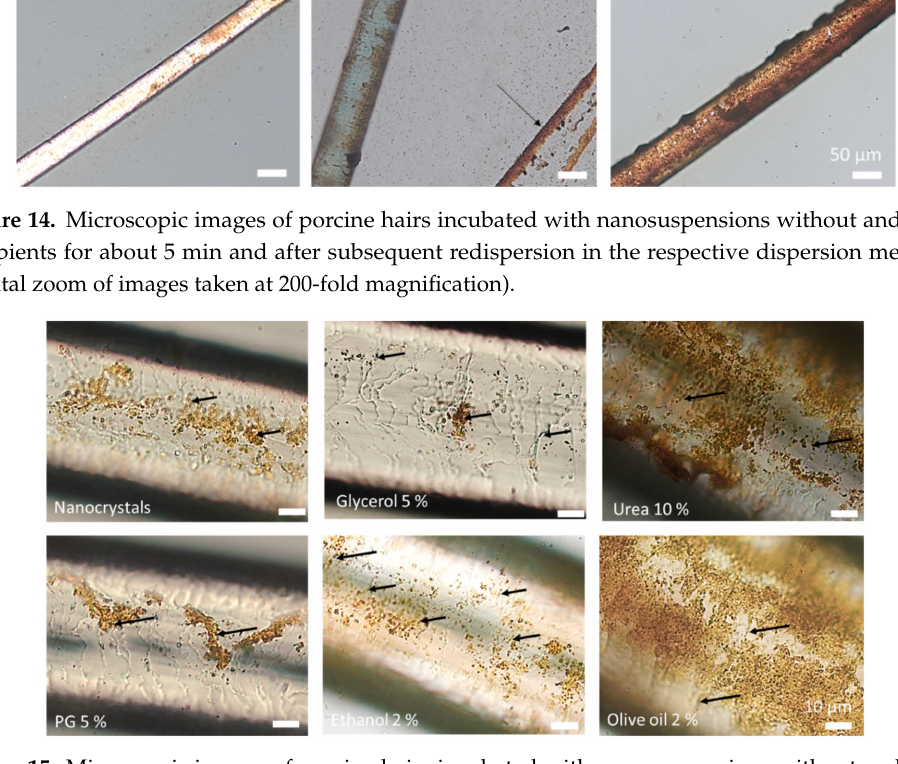
Figure 15. Microscopic images of porcine hairs incubated with nanosuspensions without and with excipients for about 5 min and subsequent re-dispersion in the respective dispersion medium (digital zoom of images taken at 1000-fold